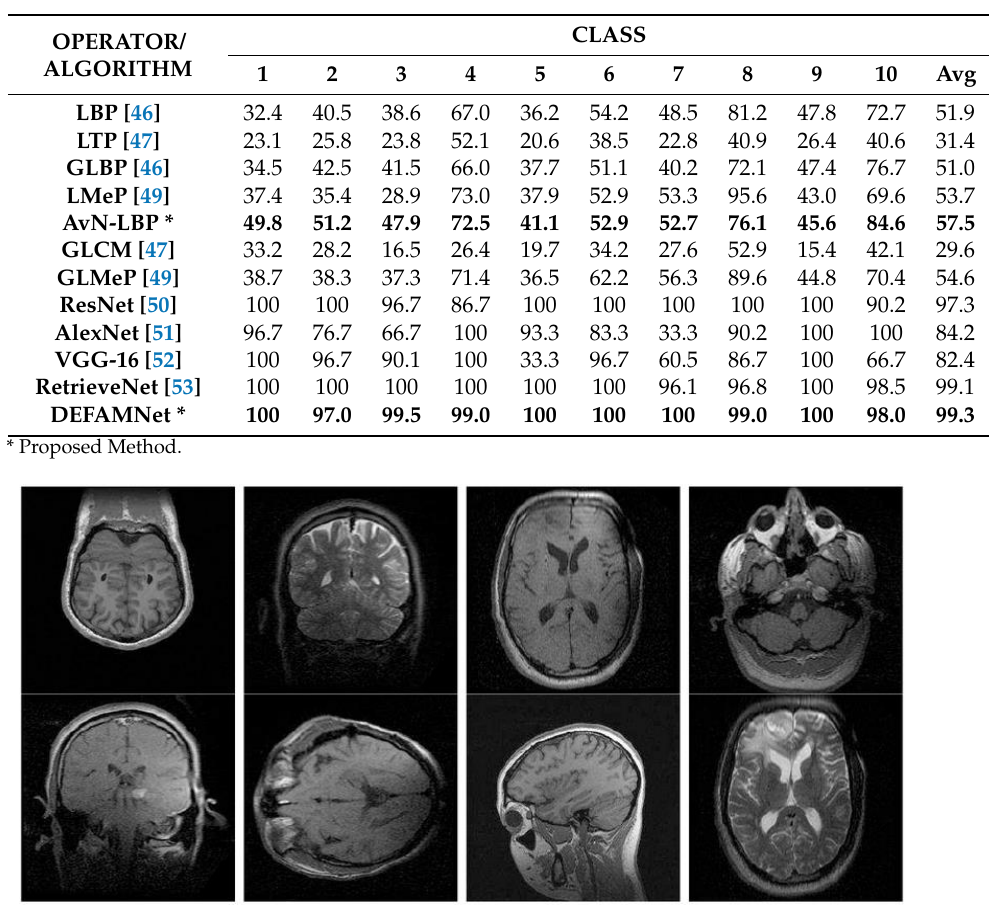
Figure 9. Sample images from different classes of the OASIS database. Table 4. Comparison of Retrieval Accuracy (ARP) on the OASIS database.